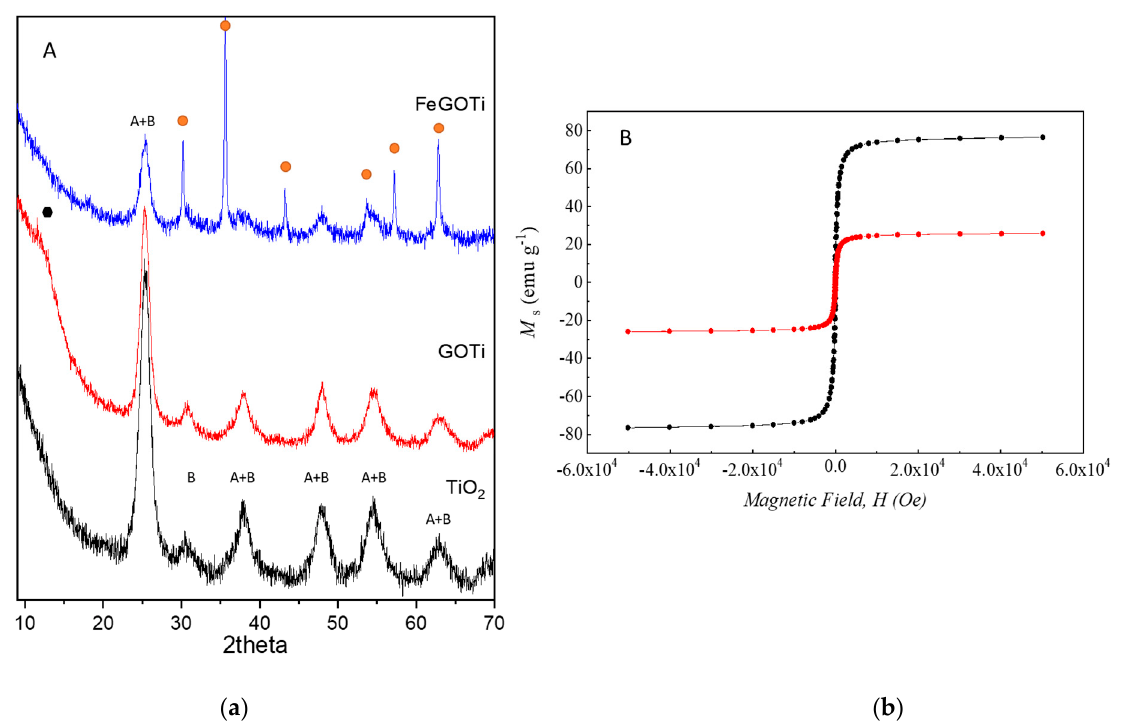
Figure 1. ( a ) XRD patterns of the solids. Identified phases were anatase (A), brookite (B), graphene oxide ( ) and maghemite/magnetite ( ). ( b ) Magnetic moment, Ms, versus applied magnetic field, H, for calcined magnetite (black) and FeGOTi catalyst (red).